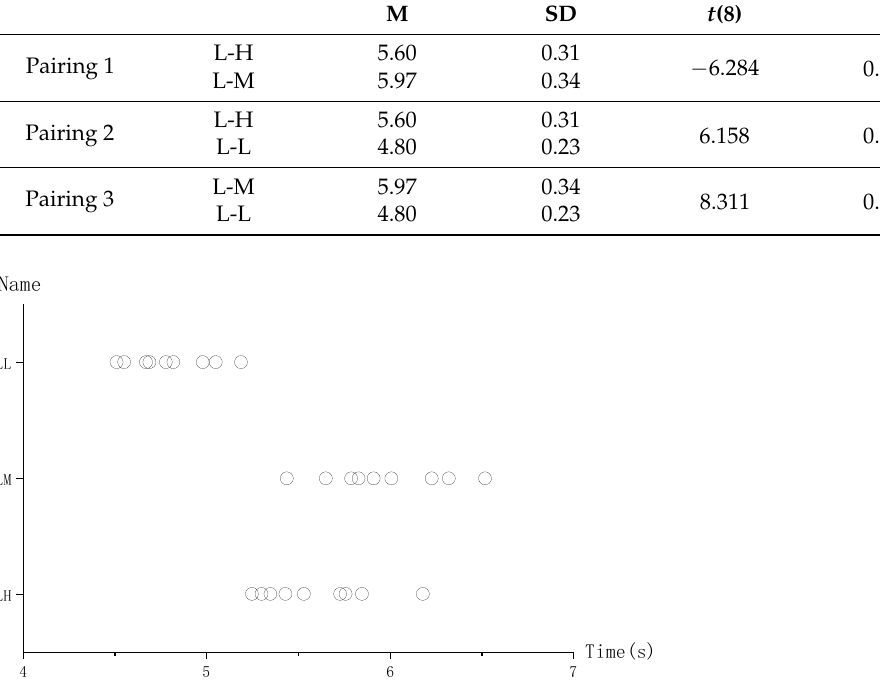
Table 4. Time distribution results table of medium